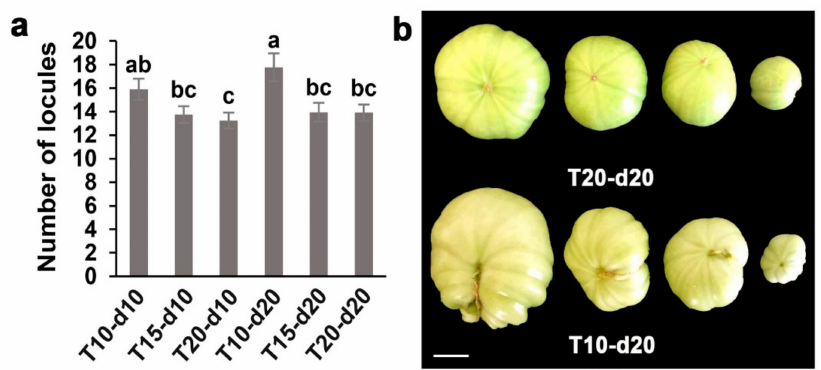
Figure 1. E ff ects of di ff erent overnight temperatures on fruit morphometrical of tomato. ( a ) The e ff ect of di ff erent overnight temperatures (T10, T15, and T20) and treatment days (10 and 20 days) on the number of locules. ( b ) The e ff ect of T10 and T20 overnight temperature treatment for 20 days on fruit malformation. The error bars represent the standard errors. Di ff erent lowercase letters represent significant di ff erences ( p < 0.05, Duncan’s multiple range test). Scale bar: 1 cm.